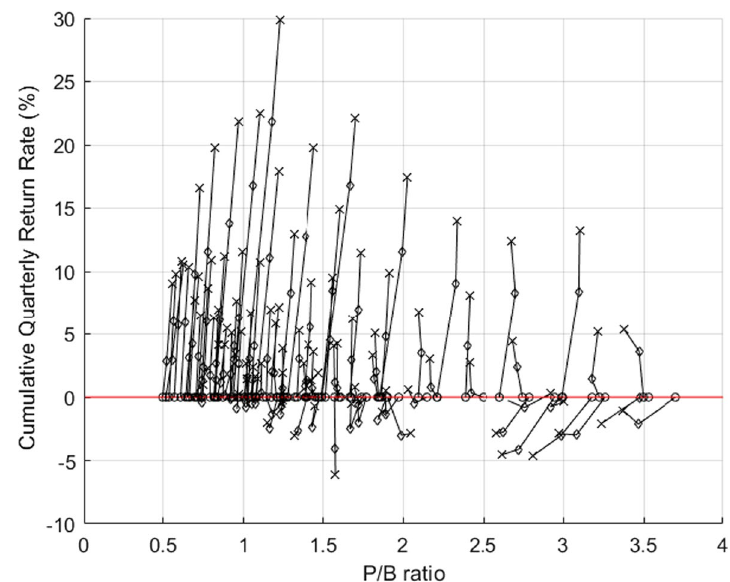
Fig. 28 Three‑view drawing: the relationship between P/B and cumulative quarterly return rates (circle, diamond, x‑mark: the data in the t, t